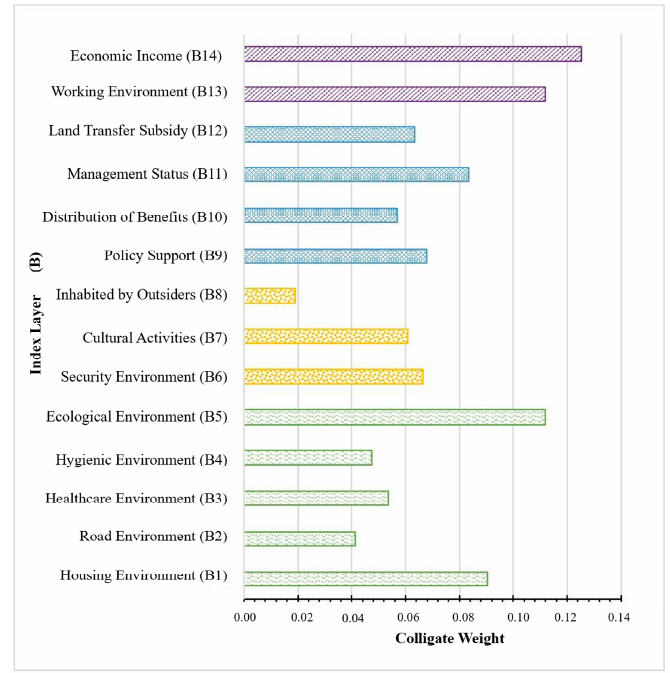
Figure 9. The weights in index layer.